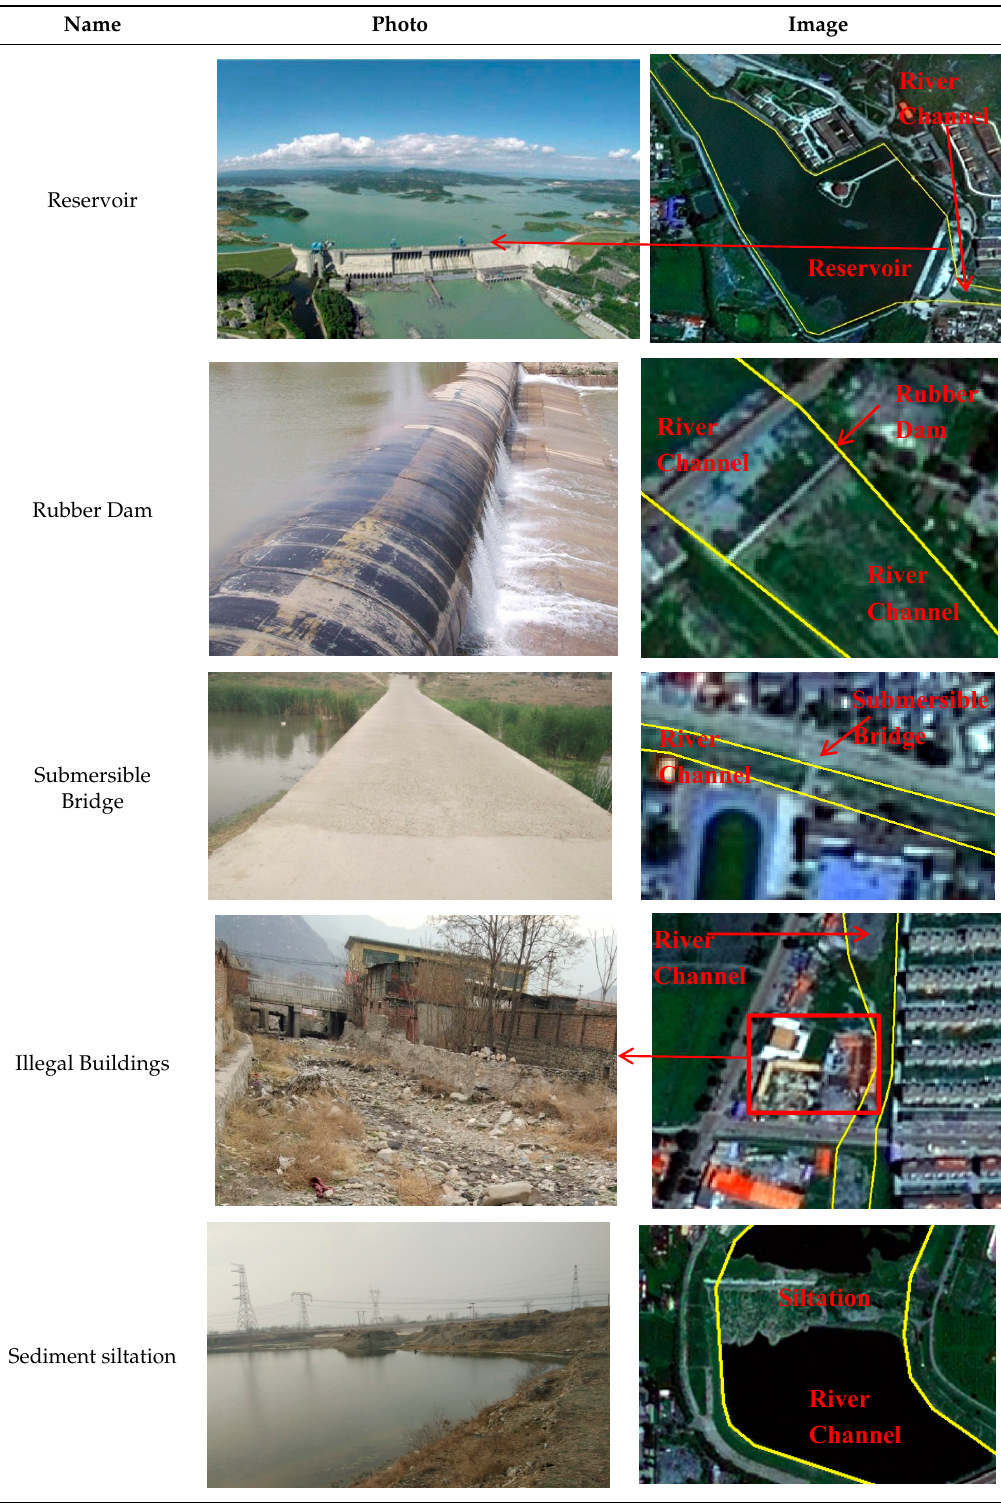
Table 2. The barriers in the field landscape and remote sensing